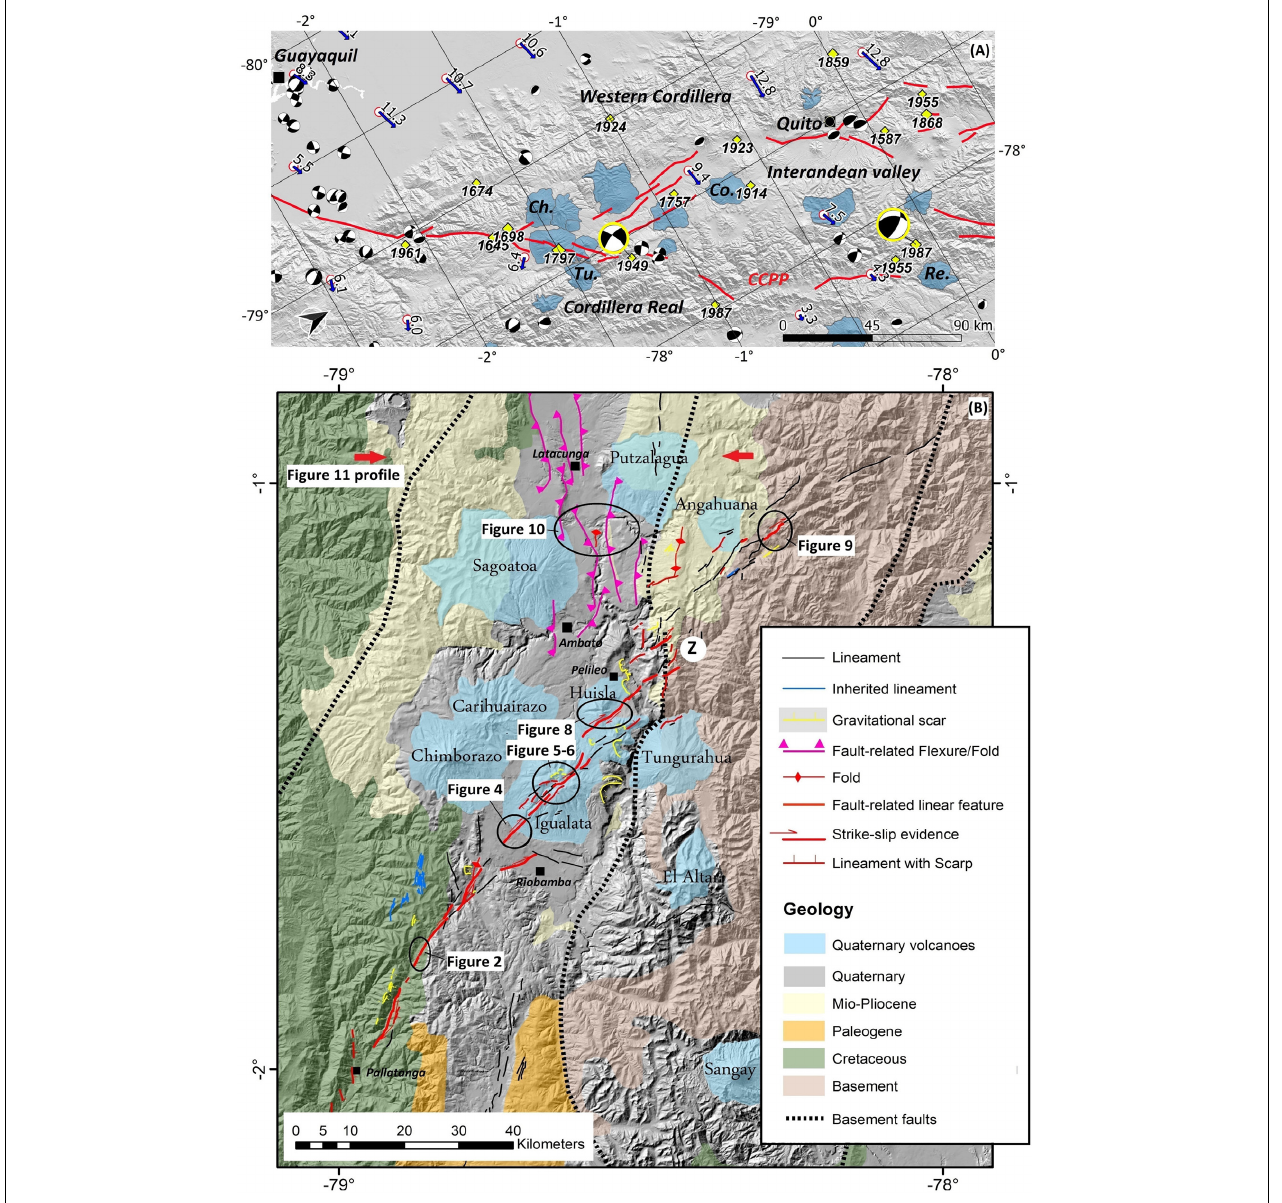
FIGURE 3 | (A) Overview of the seismicity (white dots, epicenters of earthquakes with magnitude above 6, from Beauval et al., 2010) and GPS velocities (blue arrows, from Nocquet et al., 2014) in the area of interest around the CCPP fault segments and IAV fault-related folds (simplified mapping, red lines). Blue footprints are active volcanoes from Bernard and Andrade (2016): Ch., Chimborazo; Tu., Tungurahua; Co., Cotopaxi; Re., Reventador. Focal mechanisms are from Vaca et al. (2019) (magnitude range 3.3–5.4), and focal mechanisms of Ms = 6.8 1949 Pelileo and Mw = 7.2 Reventador earthquakes (circled in yellow) are from Woodward and Clyde Consultant (1981) and Barberi et al. (1988), respectively [reported in Tibaldi et al. (1995)]. (B) Morphotectonic map resulting from the DEM and field work analyses. We define various categories of morphological lineaments: (1) Lineament with scarps are morphological features with a clear recent signature with a vertical separation of the ground surface in Quaternary deposits; (2) Strike-slip evidence are lineaments for which field (or rarely DEM) analysis has shown up the lateral displacement of a recent morphological feature; (3) Pressure ridge are elongated hills that disturb the local morphology, associated with deflection of morphological features; they are suspected to correspond to surface expression of transpressive pop-up structures due to strike-slip faulting at depth; (4) Folds are symmetrical and large-wavelength elongated disturbances of the ground surface and young sediments; (5) Fault-related flexures are asymmetrical disturbances of the surface revealing relative uplifting and subsiding blocks and then potentially corresponding to buried reverse faults. Flexure scarps are locally topped by to symmetrical folds in some places, potentially relating to a lateral component; (6) undistinguished lineaments inferred from DEM are suspected to relate to active faulting but without clear evidence of recent displacement; (7) inherited lineaments are clearly associated with basement structures (shear planes, bedding); major gravitational scars are arcuate features associated with landslides mostly located in the deeply incised Patate and Chambo Rivers’ valleys, some of them having been caused by the 1949 Pelileo earthquake (label Z); others are features associated with deep-seated gravitational slope deformation features. The simplified geological map has been digitized from the National Geological Map of Ecuador (Longo and Baldock, 1982); volcano footprints are from Bernard and Andrade (2016). White boxes locate the zoom-in figures in this